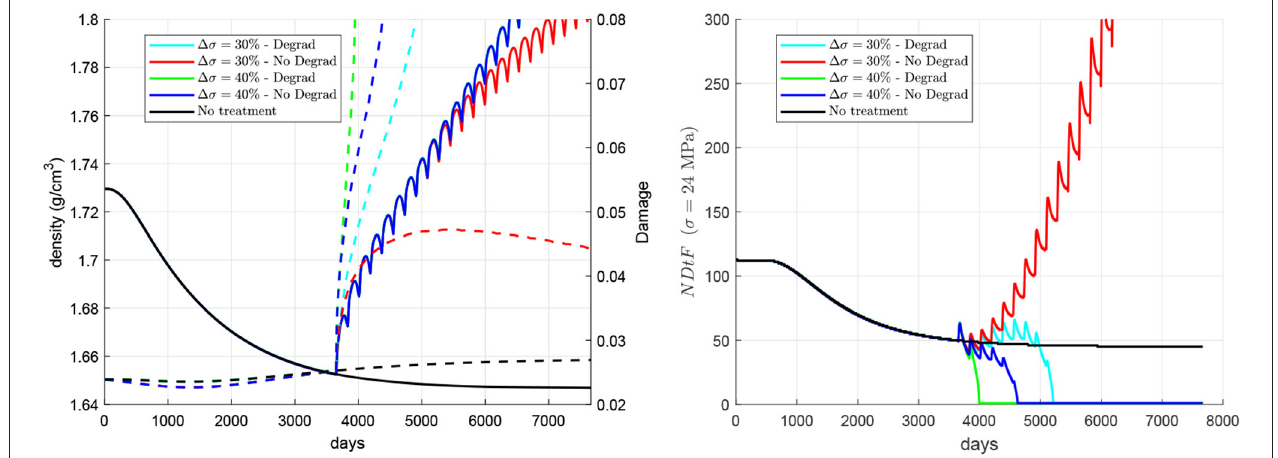
FIGURE 8 | Influence of the degradation of fatigue properties with the mineral content. Evolution of density (left, solid lines), damage (left, dashed lines), and NDtF- σ = 24 MPa (right) for treatment 60Q6. Two scenarios are considered: (a) a stepwise increase of 30% of the nominal stress coinciding with a late treatment and (b) a stepwise increase of 40%; and two models with and without considering the degradation of fatigue properties with the mineral content. Note: the red and blue solid lines in the left figure coincide, respectively, with the cyan and green solid